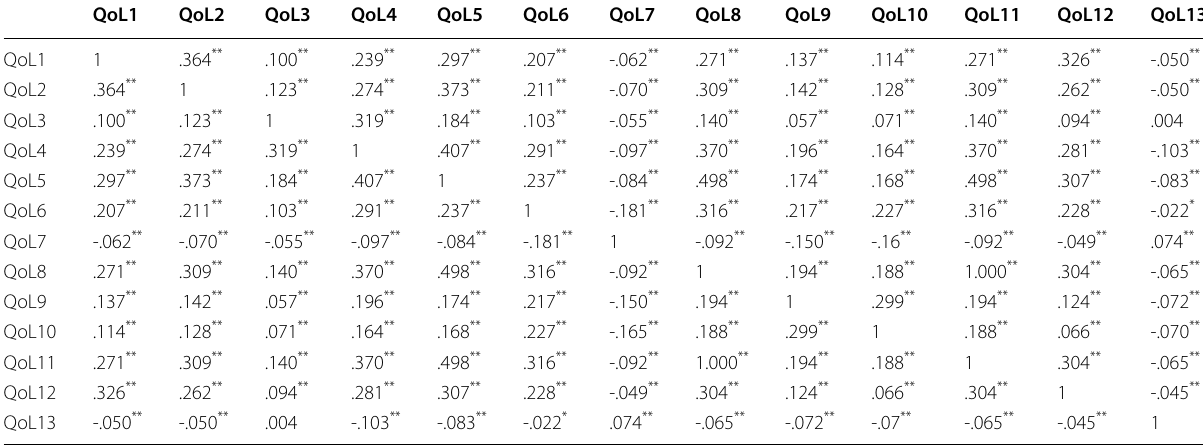
** significance at 0.001; * significance at